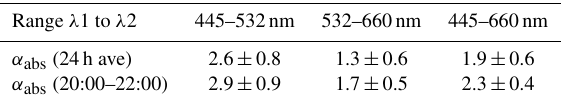
Table 4. Angström exponents of absorption, α abs , derived for 31 October 2012 at Durlacher Tor, Karlsruhe.